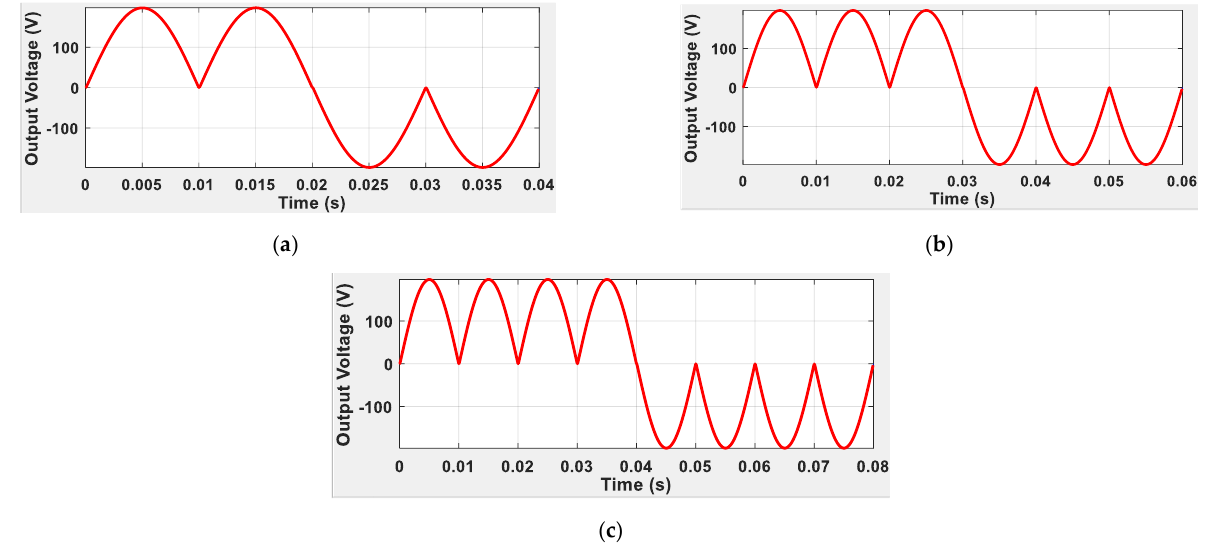
Figure 12. Waveforms of the output voltage without output voltage regulation capabilities for output frequency requirement: ( a ) one-half; ( b ) one-third; and ( c ) one-fourth.